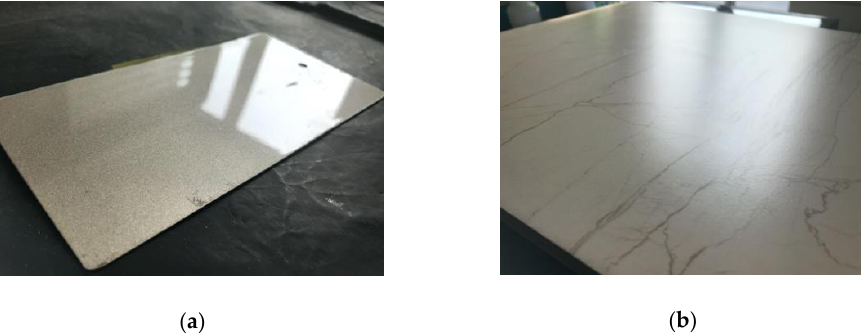
Figure 12. Waxy surfaces, which have ceramic glaze coating outside working as micro-mirrors. ( a ) The car shell sample; ( b ) the floor tile .